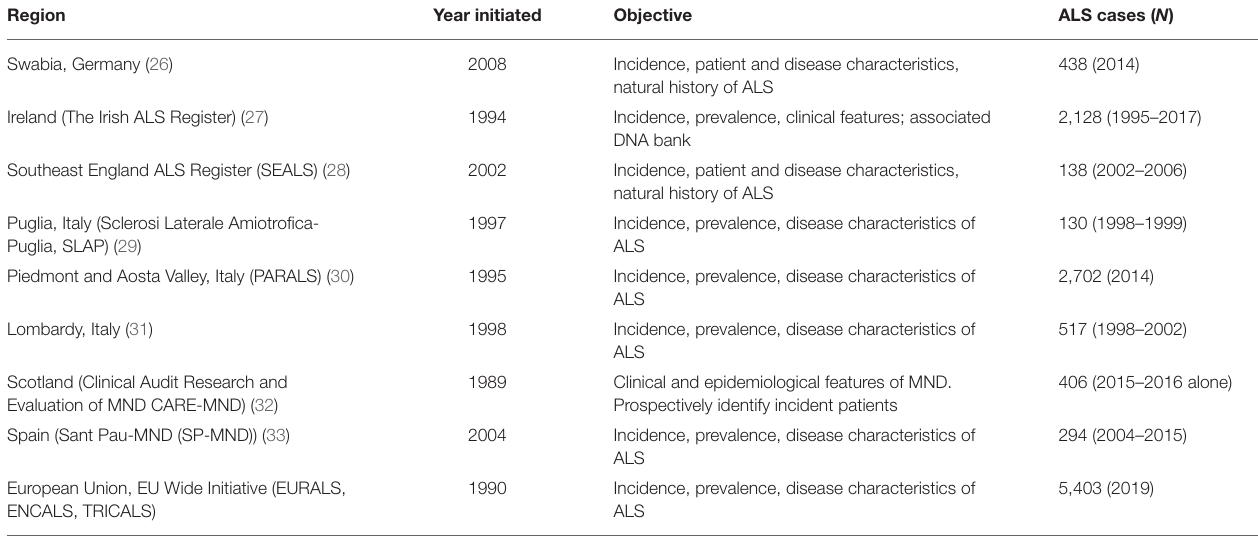
TABLE 2 | Regional registries: selected list.